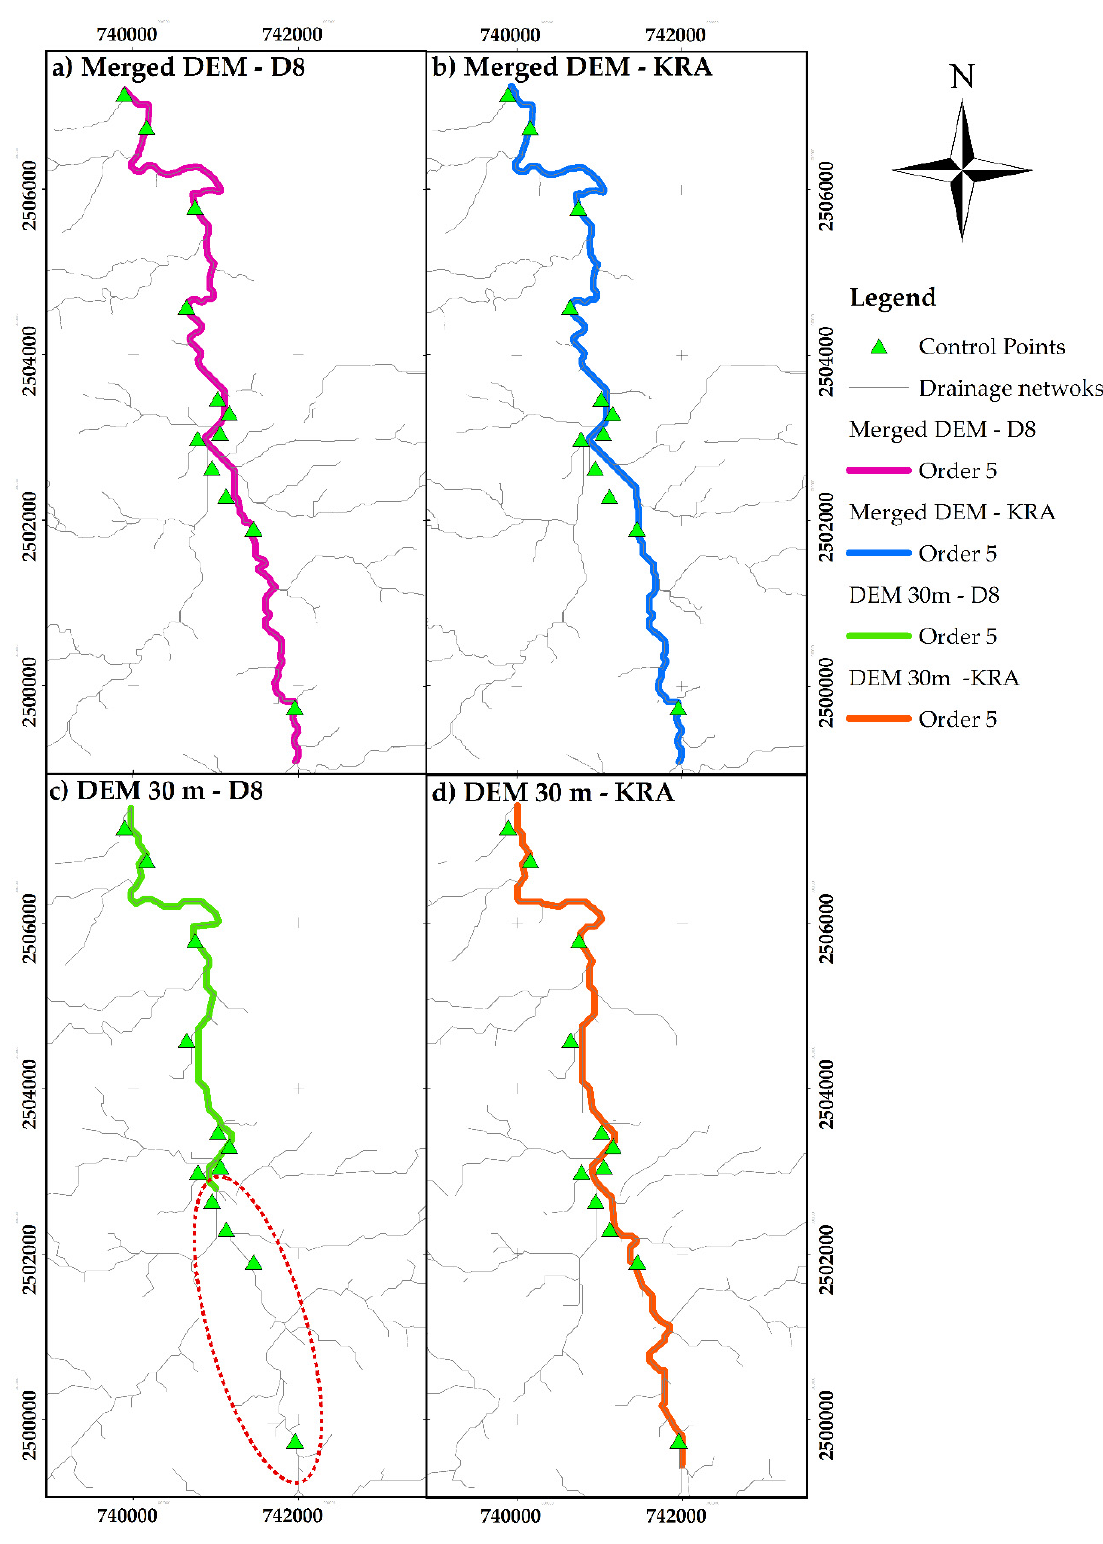
Figure 11. Drainage networks, control points, and channels of stream order 5.